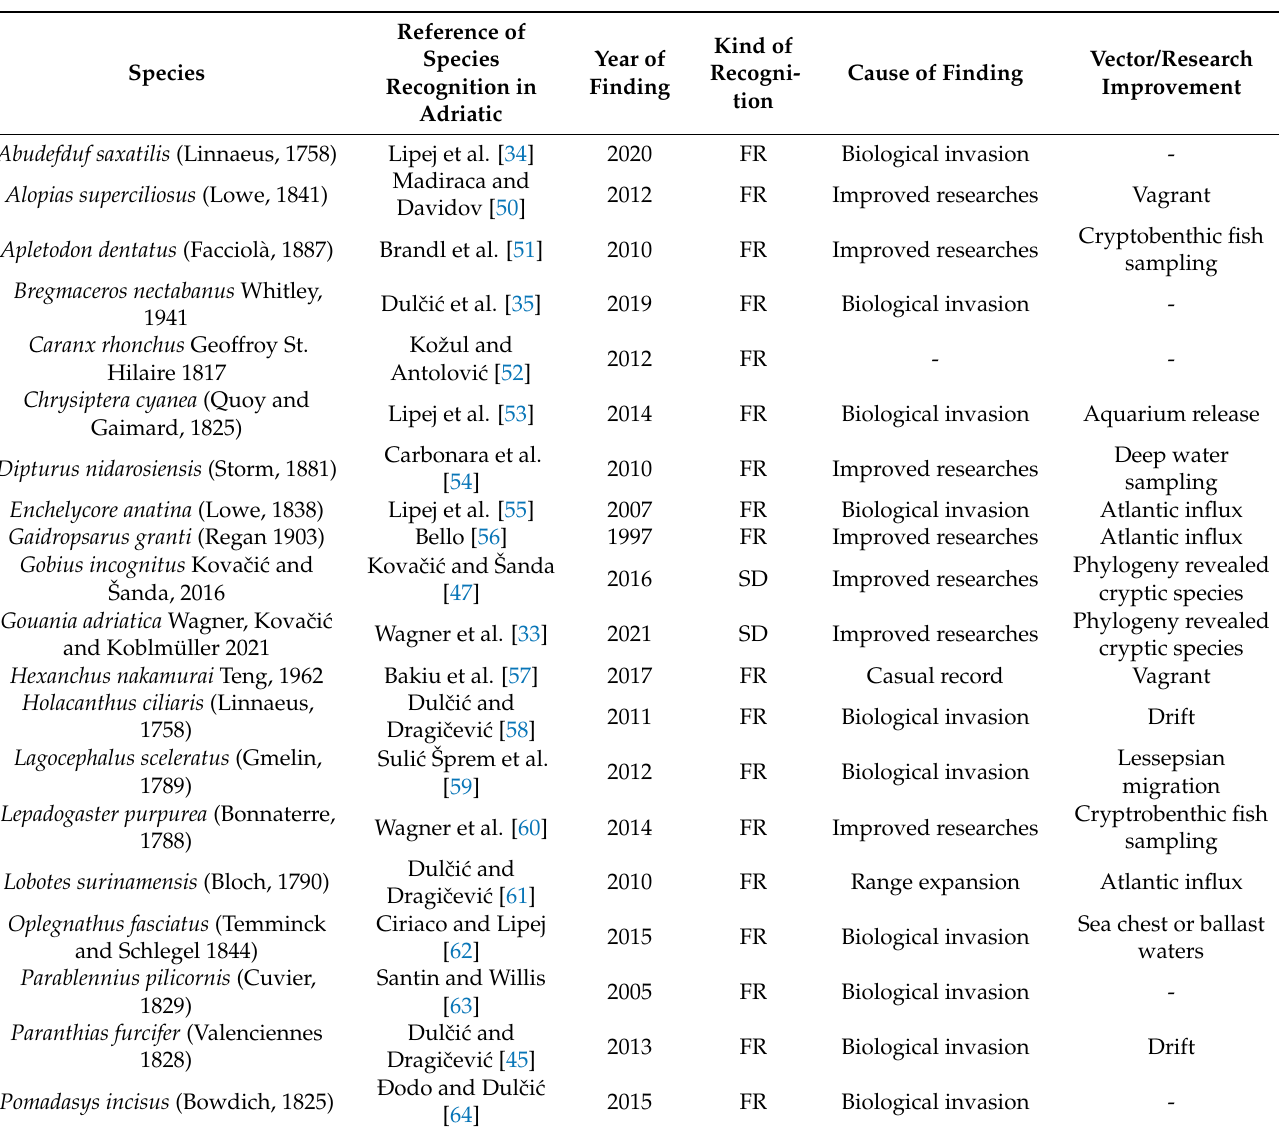
Table 3. Species first time found in the Adriatic Sea in the period 2010–2021 and the factors which facilitated their detection for the Adriatic Sea or caused their arrival in the Adriatic Sea. Legend: FR —first record, SD—species